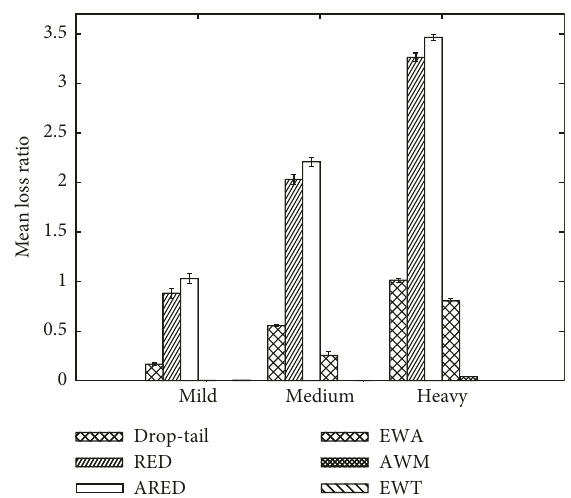
Figure 9: Mean loss ratio: Scenario